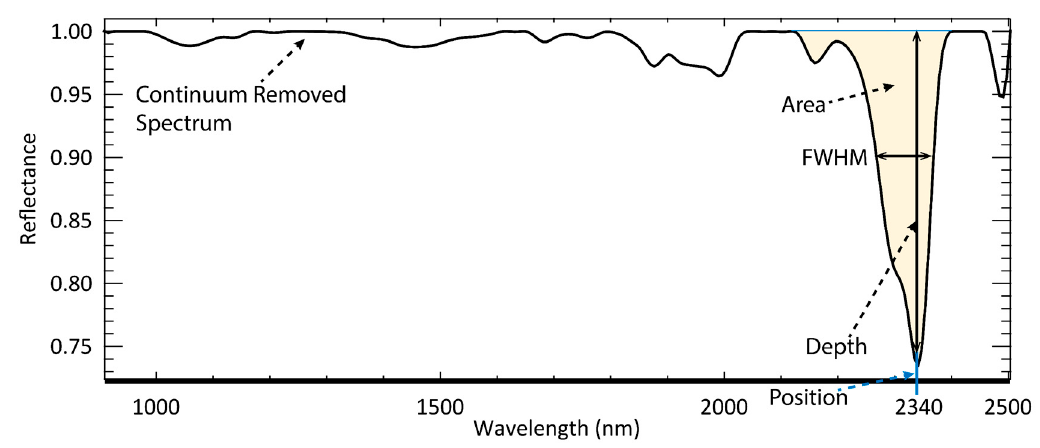
Figure 3. Spectral absorption feature characteristics modified after [25].